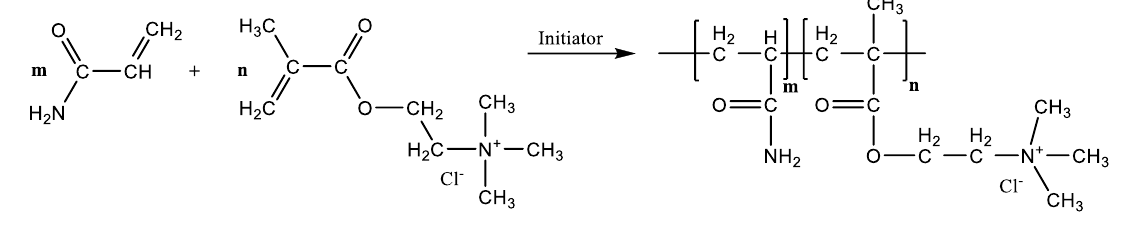
Figure 3. CPAM fusion